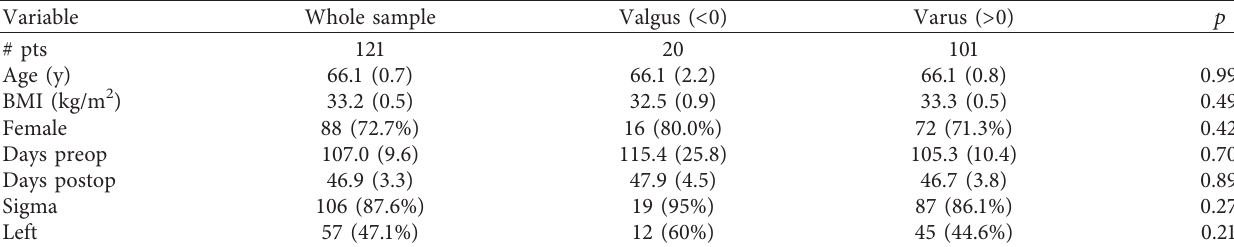
Table 1: Patient